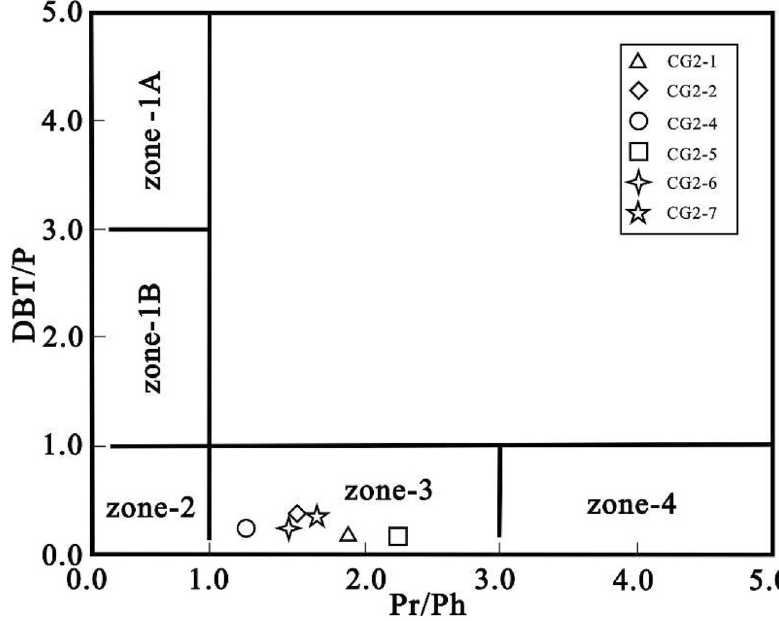
Fig. 6 DBT/P and Pr/Ph diagram for the samples used. Modified from Hughes et al.